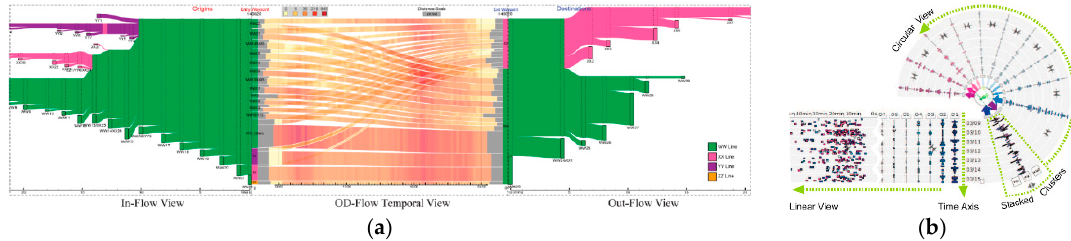
Figure 53. Two examples of OD visual analytics: ( a ) waypoints-constrained OD map with in-flow view (left), OD-flow temporal view (middle), and out-flow view (right) [137]; and ( b ) adapted OD-wheel design [138].